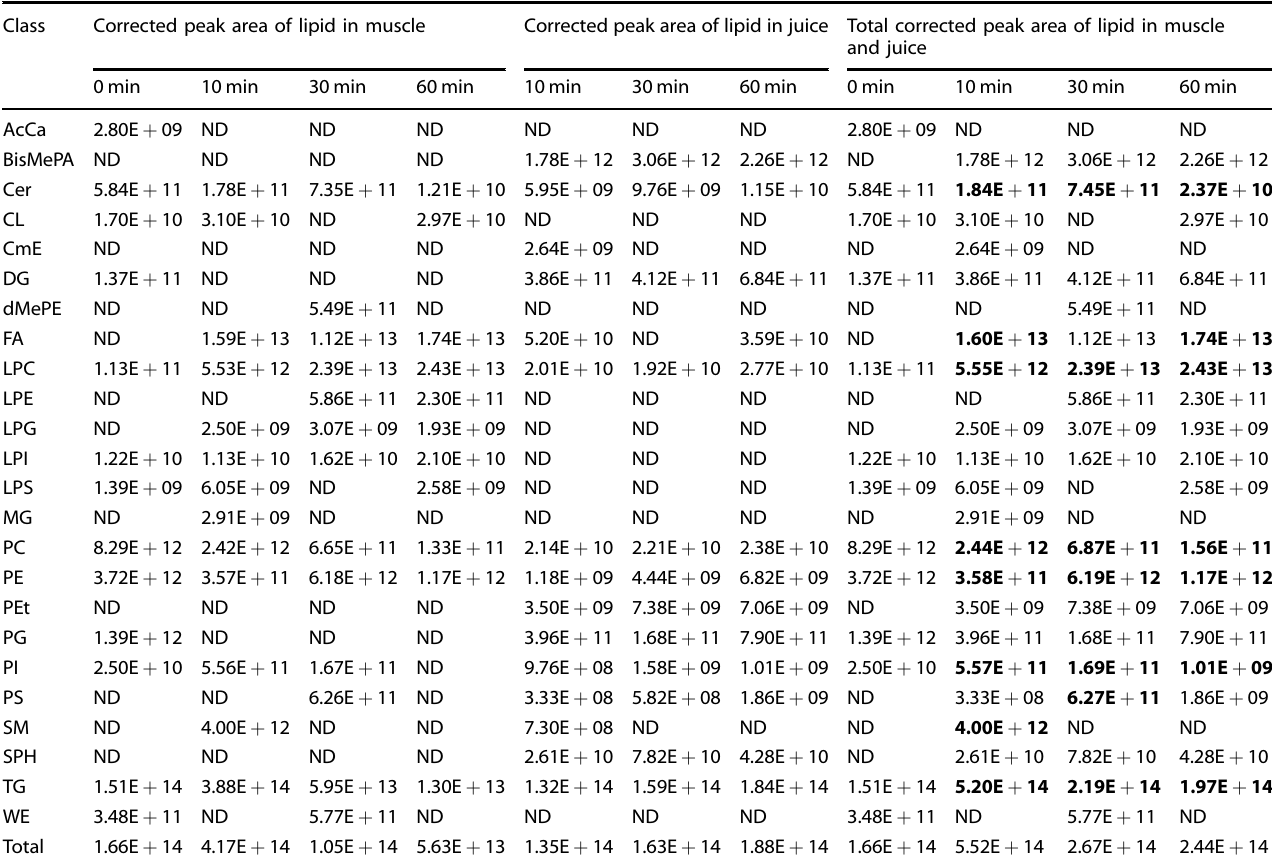
Table 2. Corrected lipidomics data of lipid classes in muscles and juices during the tilapia muscle steaming process. Class Corrected peak area of lipid in